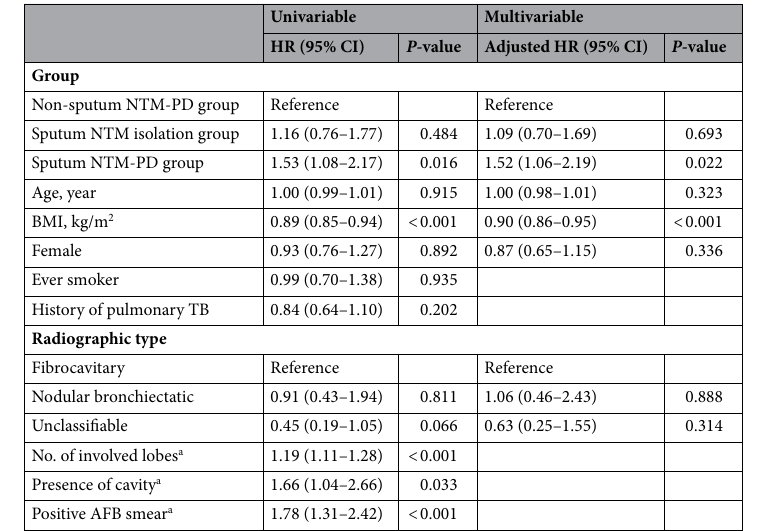
Table 2. Results of Cox proportional hazards analysis for radiographic aggravation. BMI body mass index, COPD chronic obstructive pulmonary disease, NTM nontuberculous mycobacteria, NTM-PD nontuberculous mycobacterial pulmonary disease, TB tuberculosis. a Not included in multivariable analysis owing to multicollinearity with Group